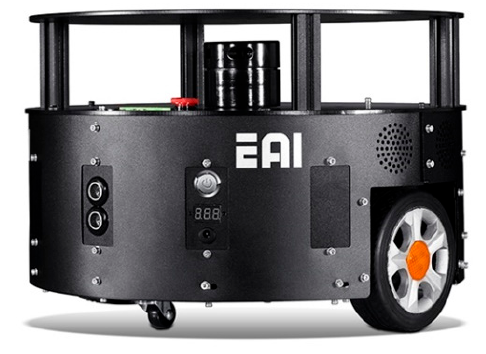
Figure 1. Laser simultaneous localization and mapping (SLAM) algorithm robot.